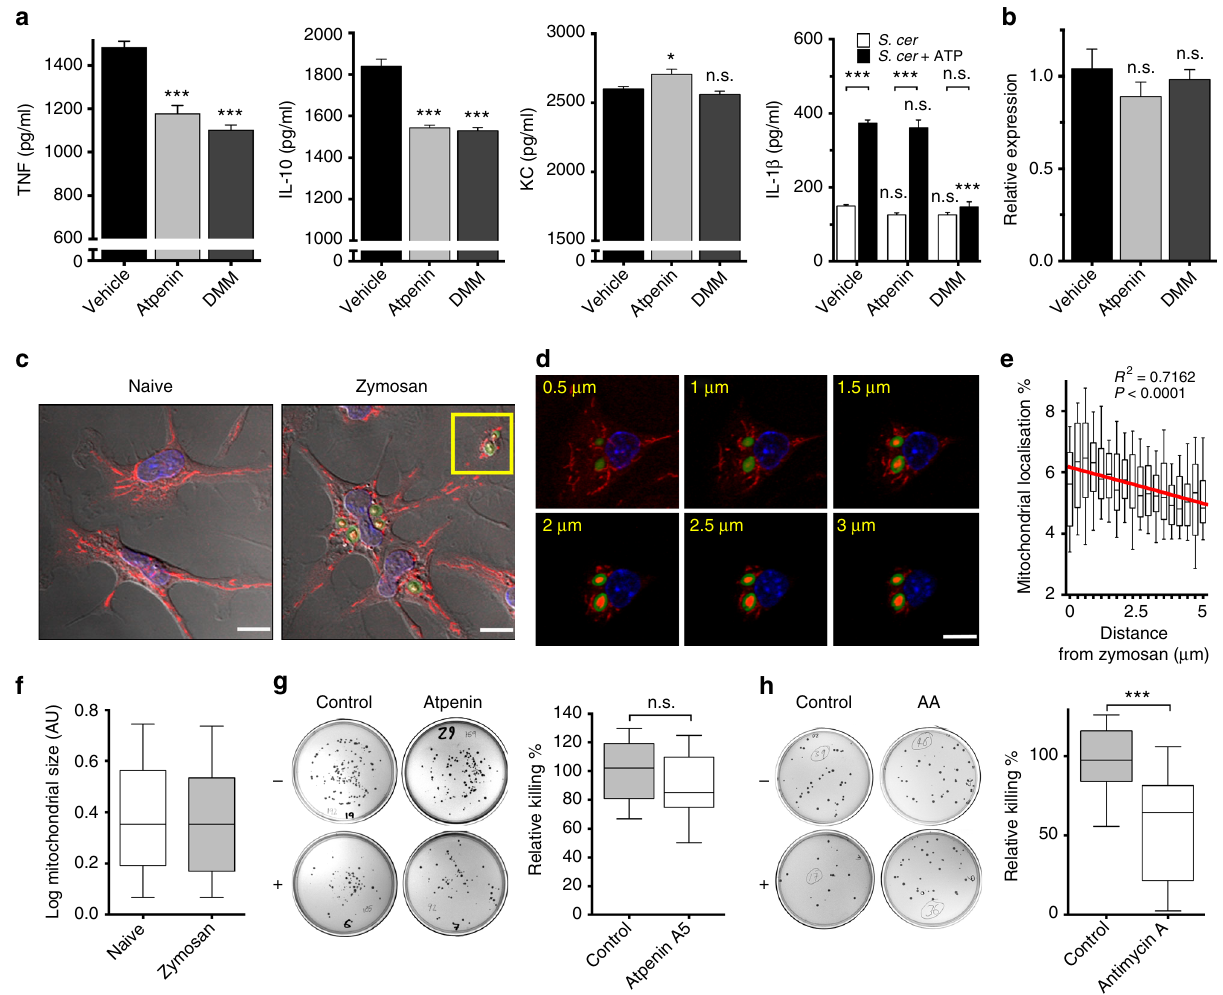
Fig. 9 The mitochondrial electron transport chain is required for antimicrobial function in peritoneal tissue-resident macrophages. a Quanti fi cation of cytokines from peritoneal tissue-resident macrophage (pTRMØ) supernatant 24 h after Saccharomyces cerevisiae ( S. cerevisiae) (50 μ g/ml) ± dimethylmalonate (DMM,10 mM) or ± atpenin A5 (1 μ M). The far-right panel shows IL-1 β after 1 h post-stimulation with adenosine triphosphate (ATP, 3 mM), 23 h after S. cerevisiae . Data ( n = 4 separate wells per group) represent two independent experiments. For TNF, IL-10 and KC, data were analysed by one-way ANOVA with Dunnett ’ s post-tests; for IL-1 β , data were analysed by two-way ANOVA with Sidak ’ s post-tests vs vehicle control or vs no ATP as indicated (interaction p < 0.0001, ATP p < 0.0001, complex-II p < 0.0001). Error bars = mean ± SEM. b Relative expression of Il1b RNA from samples in a . c Representative photographs of pTRMØ. In c , d , zymosan-AlexaFluor488 (5 μ g/ml) are green, mitochondria labelled with Mitotracker Red CMX-Ros (25 nM) are red, whereas the nuclei are labelled blue with 6-diamidino-2-Phenylindole (DAPI,125 ng/ml). The yellow box denotes mitochondria surrounding zymosan. Zymosan cores can be seen with non-speci fi c Mitotracker Red fl uorescence. d A characteristic z -stack showing mitochondria surrounding the phagolysosome. The yellow numbers denote distance from coverslip. e Quanti fi cation of the number of Mitotracker Red positive pixels expressed as percentage of total (termed mitochondrial localisation %) at different radial distances from zymosan. Data shown are 53 zymosan particles from fi ve images. Data were analysed by a one-way ANOVA ( p < 0.0001) with a linear regression post-test shown. f Box and whisker plots showing quanti fi cation of size for > 800 mitochondrial units per group taken from fi ve images of pTRMØ in the presence or absence of zymosan-AlexaFluor488. g Representative pictures (left) of microbial plates with S. cerevisiae colonies. Data shown are from S.cerevisiae cultured ± pTRMØ with atpenin A5 (1 μ M) or control for 4 ½ h. The graph on the right shows quanti fi cation of the average microbial killing. Data are from three experiments ( n = 13 per group) and were analysed by two- way ANOVA (interaction + experimental repeat p = 0.26, atpenin A5 p = 0.10). h Representative pictures (left) and quanti fi cation of data (right) as in e , but with antimycin A (1 μ M) or control. Data are from four experiments ( n = 18 per group) and were analysed by two-way ANOVA (interaction + experimental repeat p = 0.10, antimycin A p < 0.0001). Whiskers e – h show 10 – 90% of the range. White scale bars are 10 μ